Question: Author a descriptive caption for the visualization shown.
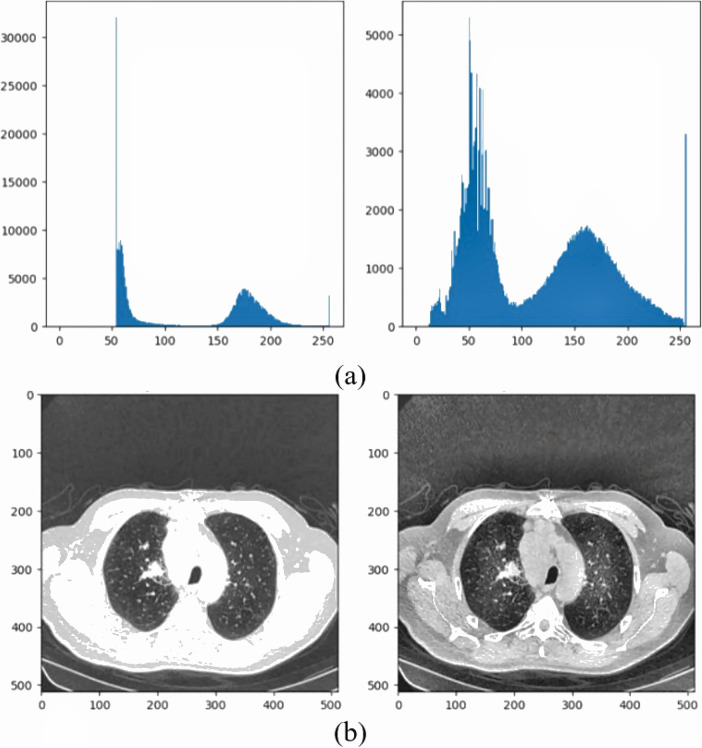
Answer: Modifications of histogram (a) and image (b) before (left) and after (right) applying CLAHE technique.